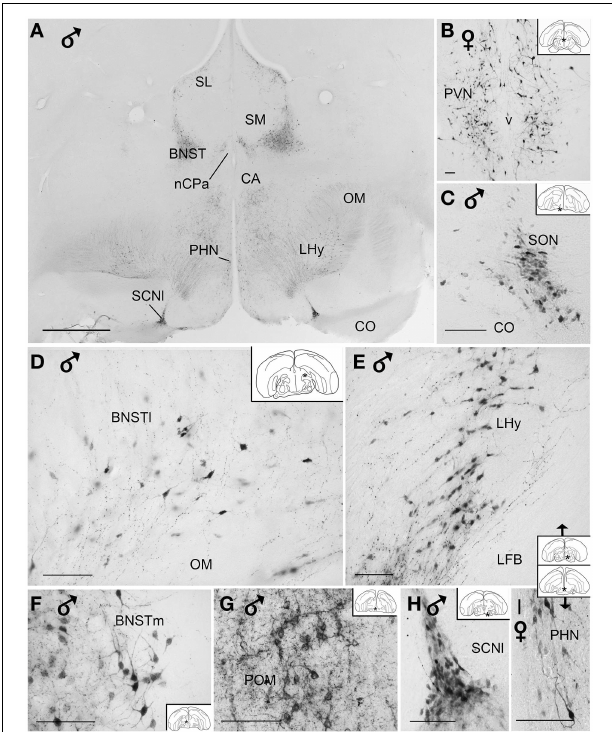
FIGURE 4 | (A) Low power photomicrograph showing the distribution of vasotocin-like immunoreactive neurons and fibers in the diencephalon of blue tits. (B–I) High power photomicrographs of vasotocin-like immunoreactive perikarya of the brain blue tits. (B) hypothalamic paraventricular nucleus, (C) supraoptic nucleus, (D) bed nucleus of the stria terminalis, pars lateralis, (E) lateral hypothalamic area, (F) bed nucleus of the stria terminalis, pars medialis, (G) medial preoptic nucleus, (H) lateral suprachiasmatic nucleus, (I) hypothalamic periventricular nucleus. Inset: stars indicate the location of the photographed field on the topogram.Calibration bar 100 µ